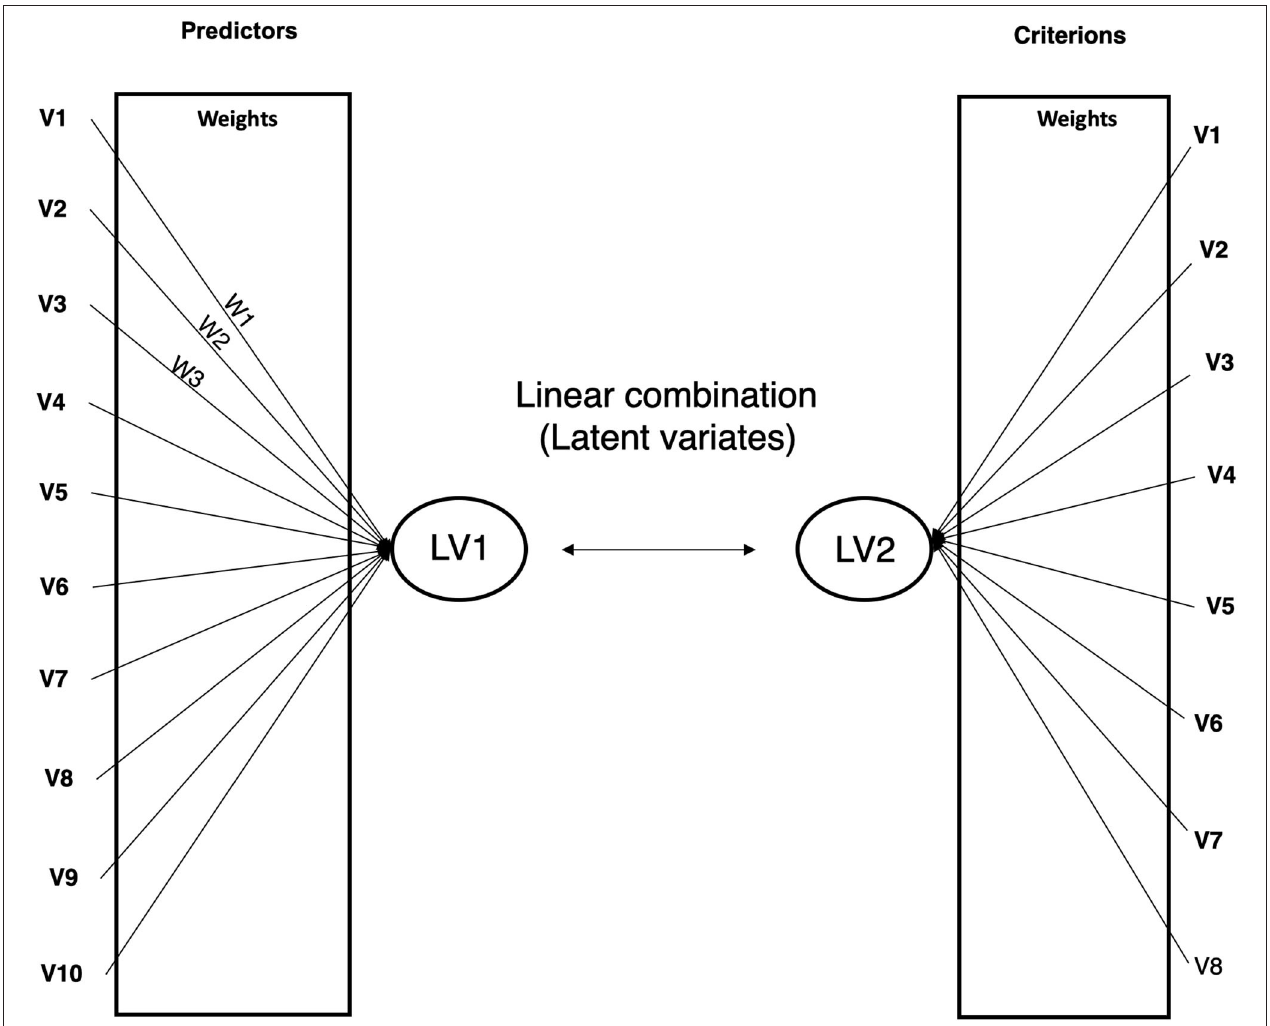
FIGURE 1 | Graphical representation of canonical correlation analysis. LV, latent variate. W, variable’s